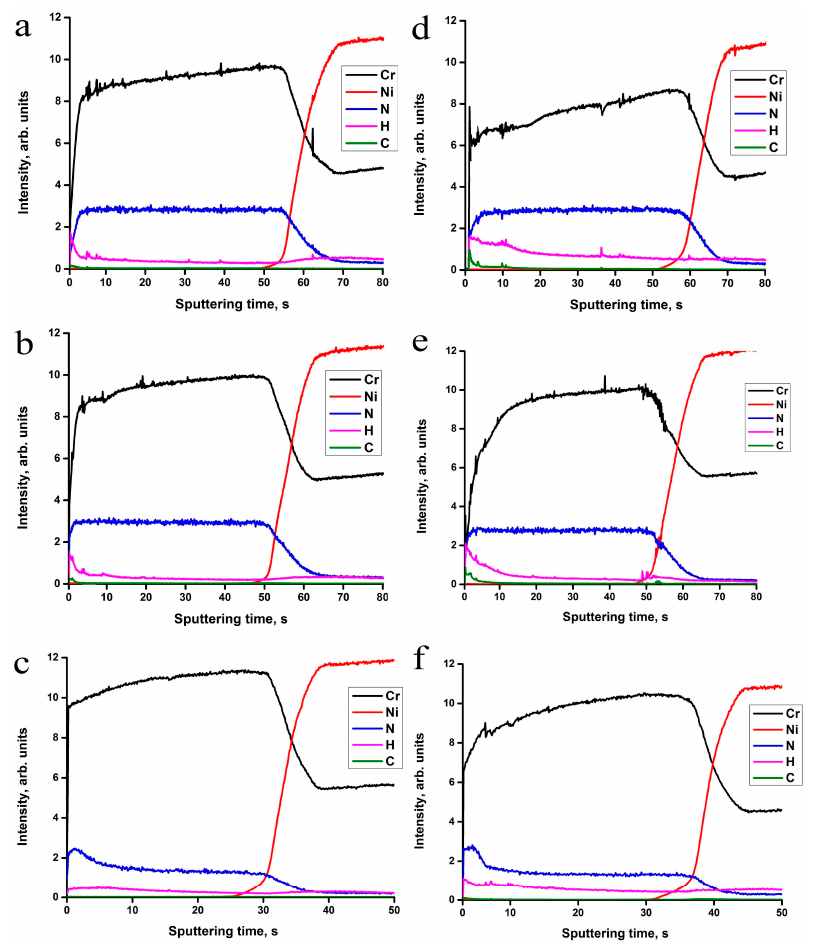
Figure 7. GDOES profiles of elements ( a ) 60 V, ( b ) 90 V, and ( c ) 120 V as-deposited, and ( d ) 60 V, ( e ) 90 V, and ( f ) 120 V hydrogen-exposed CrN x coatings on IN718